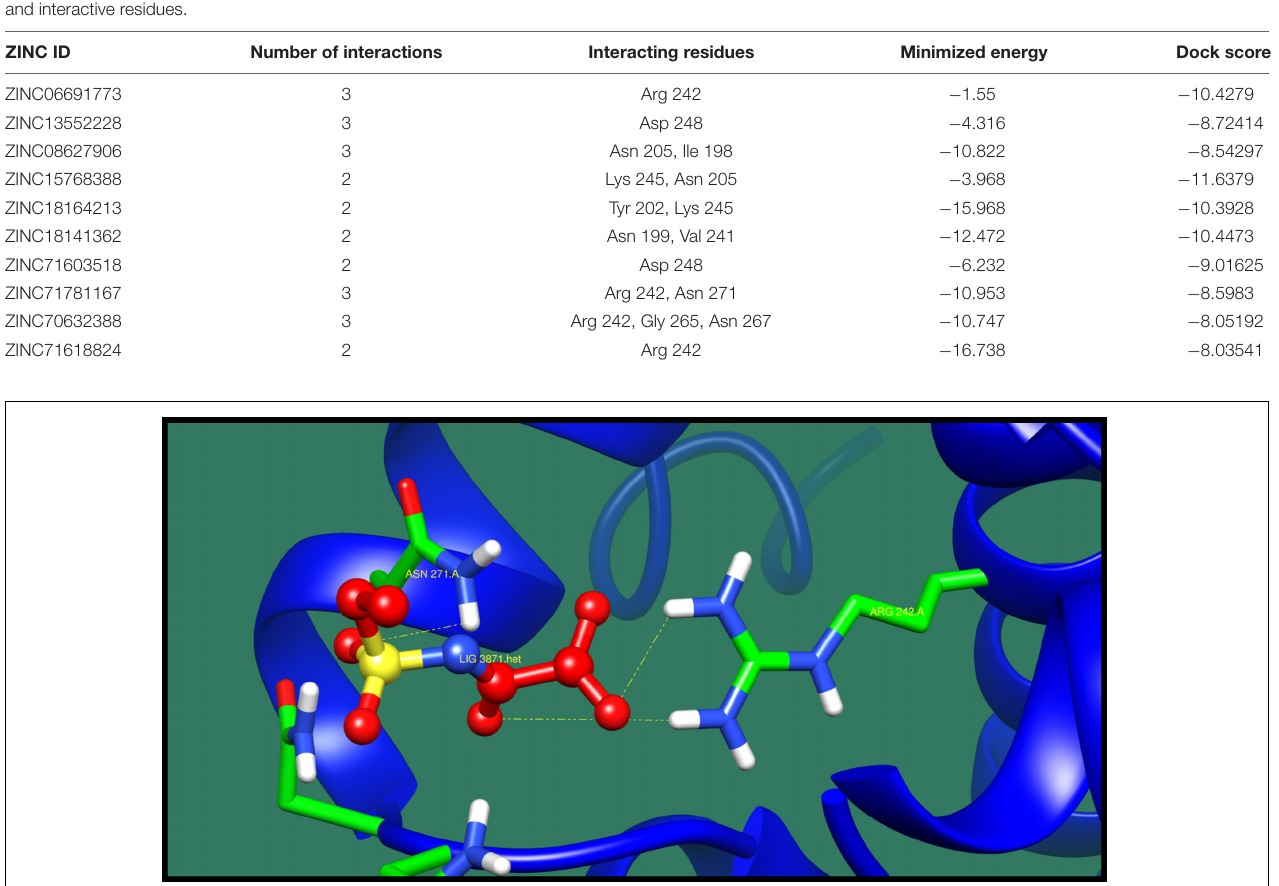
TABLE 11 | AraC family transcriptional regulator and its interaction profile with docked compounds, their ZINC ID, minimized energy, number of interactions, dock score, and interactive residues.